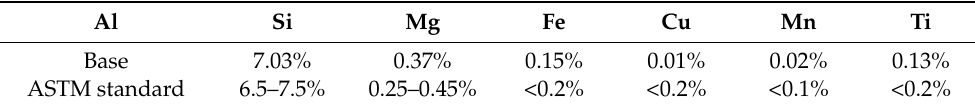
Table 2. Percentage of A356 aluminum alloy elements.